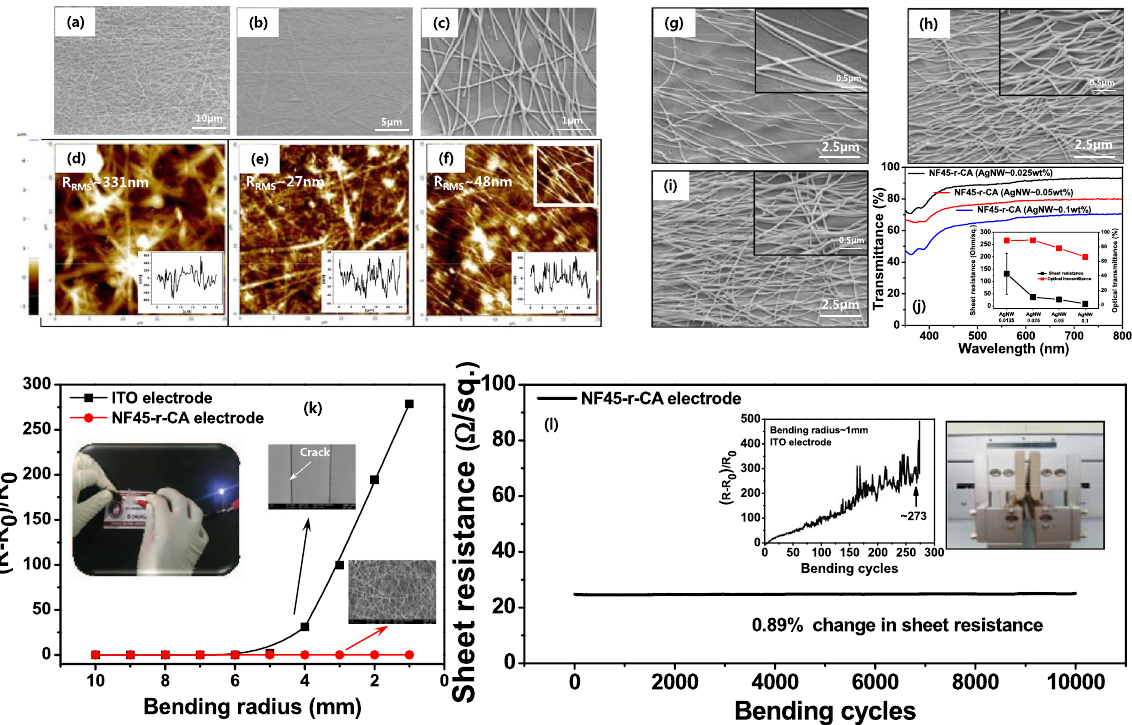
Figure 2. FE-SEM ( a–c ) and AFM ( d–f ) images of as-spun nylon 6 nanofiber membrane, the NF45-r-CA film, and AgNWs-coated transparent NF45-r-CA electrode. The inset in AFM images shows the profiles marked on the image, corresponding to the red line in the image. ( g–i ) Surface morphologies (g: 0.025%, h: 0.05%, i: 0.1%) and optical transmittance ( j ) of the NF45-r-CA transparent electrodes with different concentrations of AgNWs. The right inset shows the relationship between the sheet resistance and the optical transmittance of the NF45- r-CA transparent electrodes with different concentrations of AgNWs. ( k ) Relative change in the sheet resistance of the ITO and NF45-r-CA electrodes as a function of bending radius. The left inset shows visual inspection of the NF45-r-CA electrodes after folding, suggesting an excellent foldable property, and SEM images of each ITO and NF45-r-CA electrodes after bending test. ( l ) Repeated bending test of the NF45-r-CA electrodes for 10,000 cycles at an extreme bending radius of 1 mm. The right inset shows the relative change in the sheet resistance of the ITO electrode during the repeated bending test and visual inspection of bending